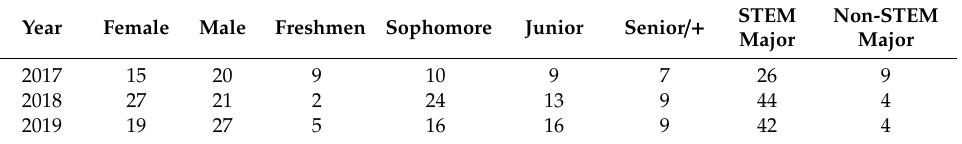
Table 3. Student demographics from 2017, 2018, and